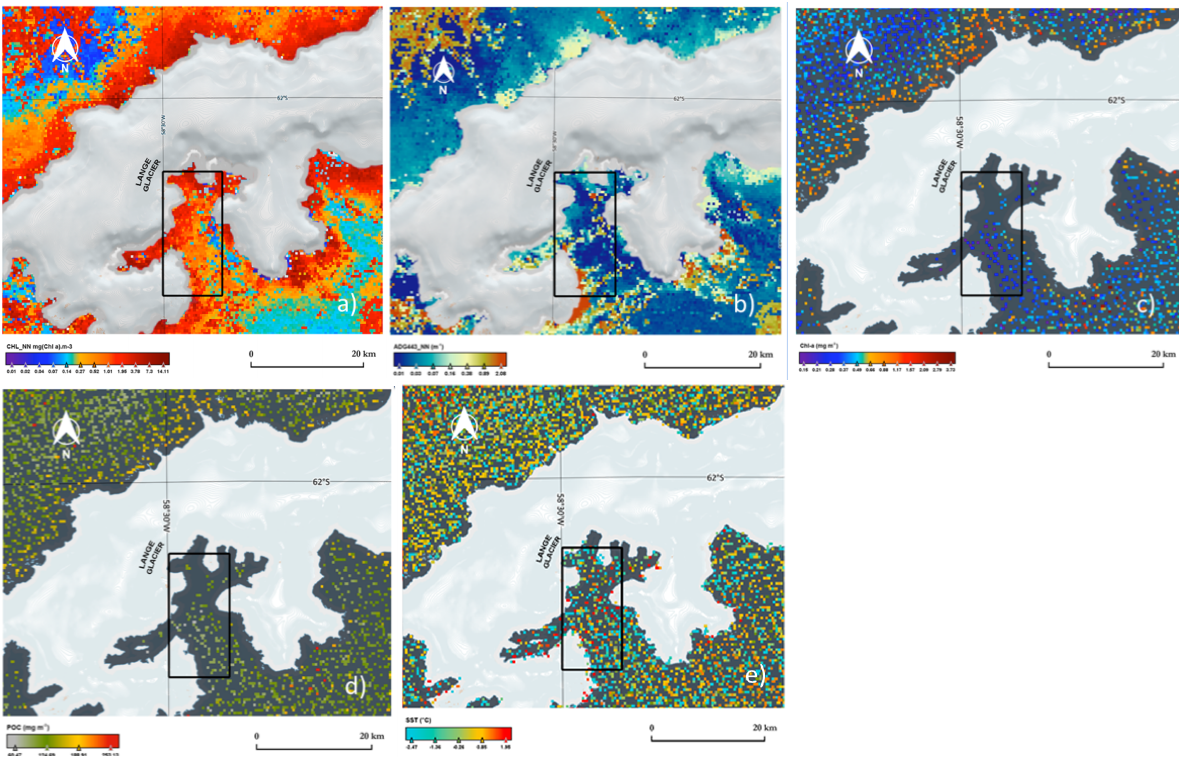
Figure 8. Monthly mean composites from February 2019: a) Chl-a OLCI, b) CDOM OLCI, c) Chl-a- MODIS d) POC MODIS and e) SST